Question: Name the type of graph shown.
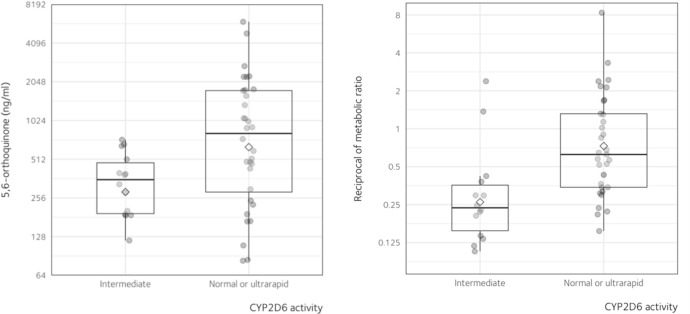
Answer: box